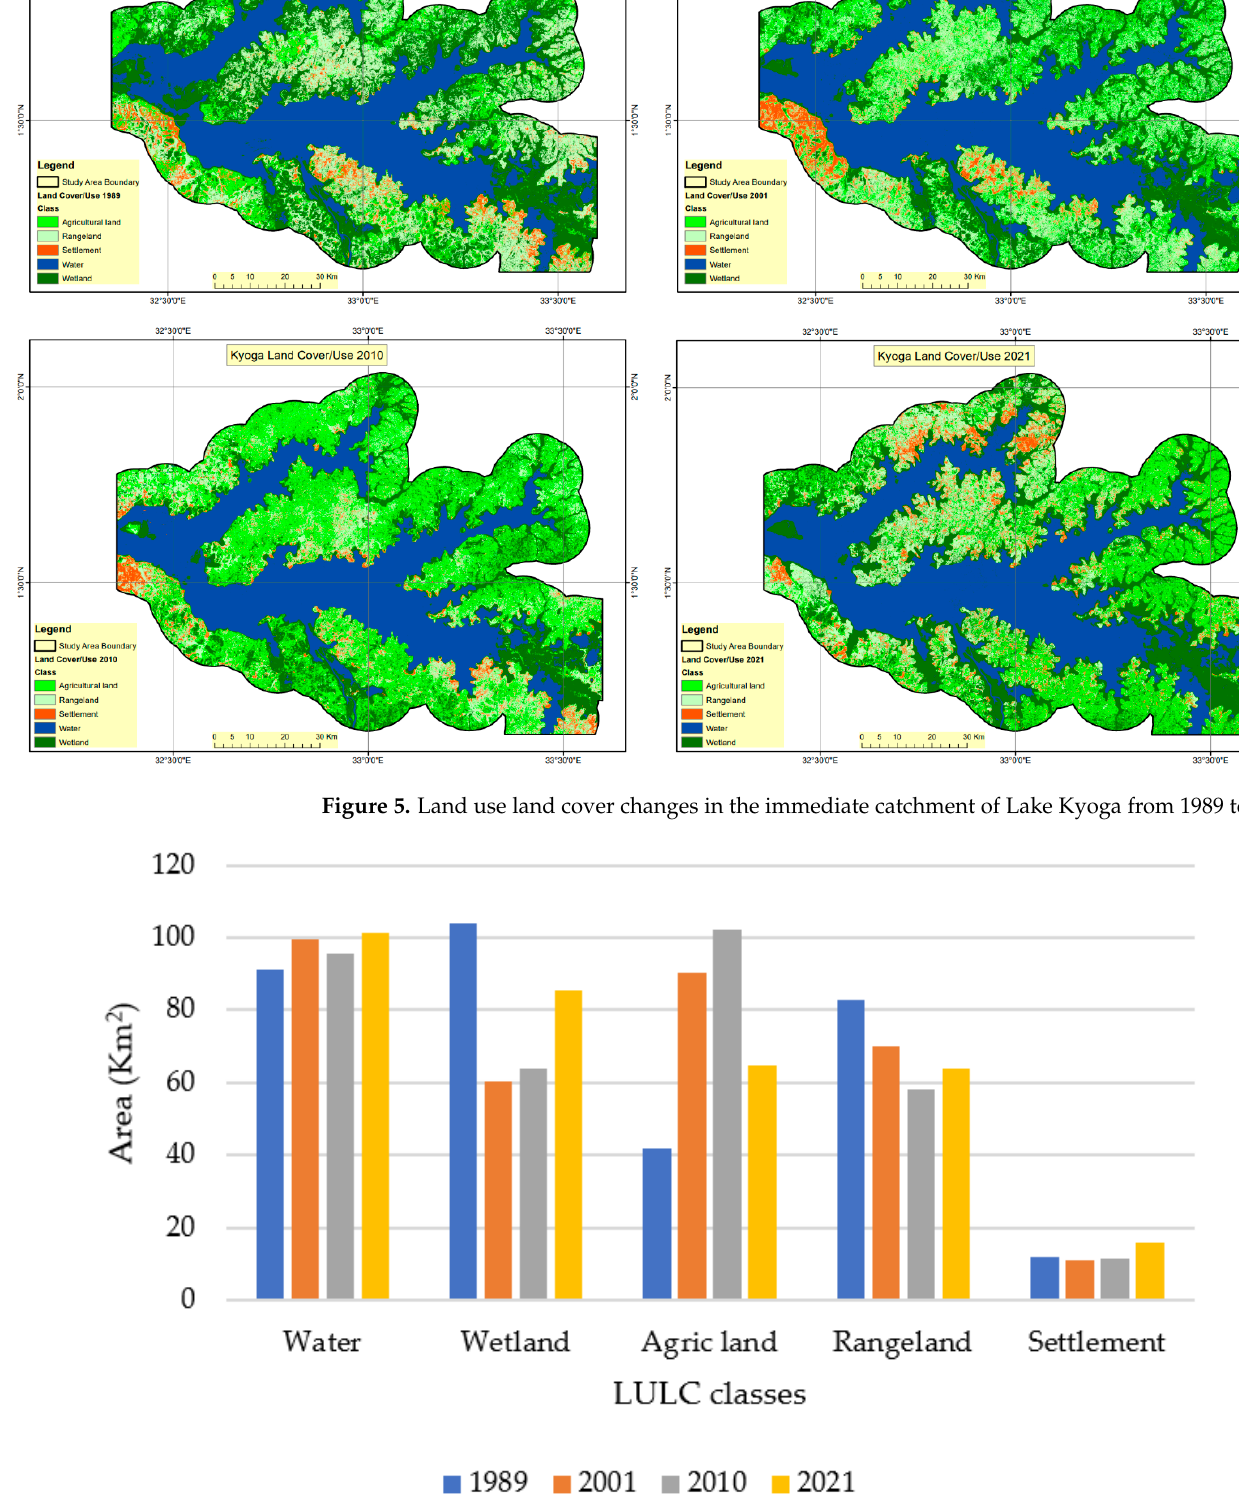
Figure 6. Trends of LULC changes from 1989 to 2021 within the Lake Kyoga catchment.